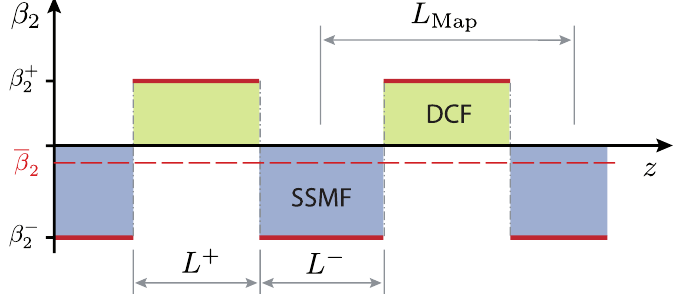
Figure 6. Dispersion-managed fiber consists of alternatingly normally (dispersion compensating fiber (DCF)) and anomalously dispersive fiber (standard single mode fiber (SSMF)) segments. The dispersion parameter β 2 alternates between values of β + respectively. The dispersion map period is L map = L + + L −